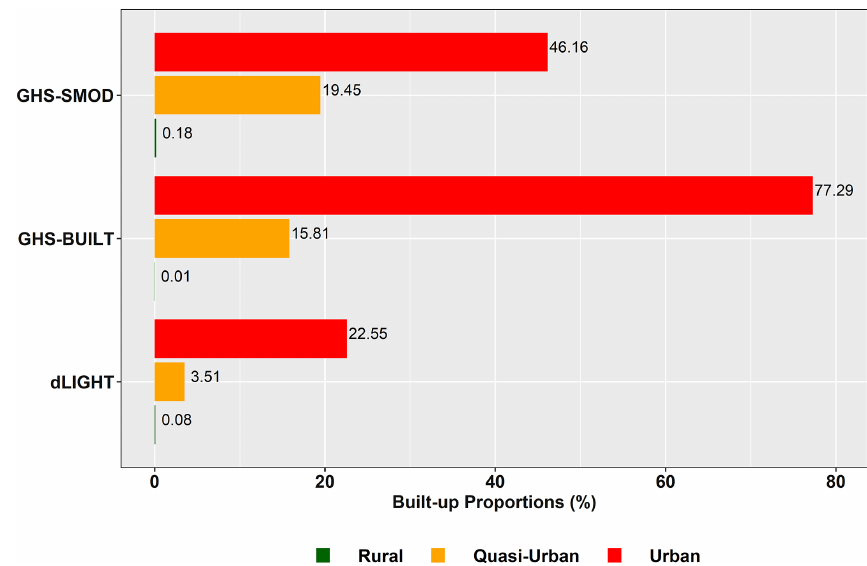
Figure 14. Built-up density of urban, quasi-urban and rural by different urban-proxy data sets, 2015.